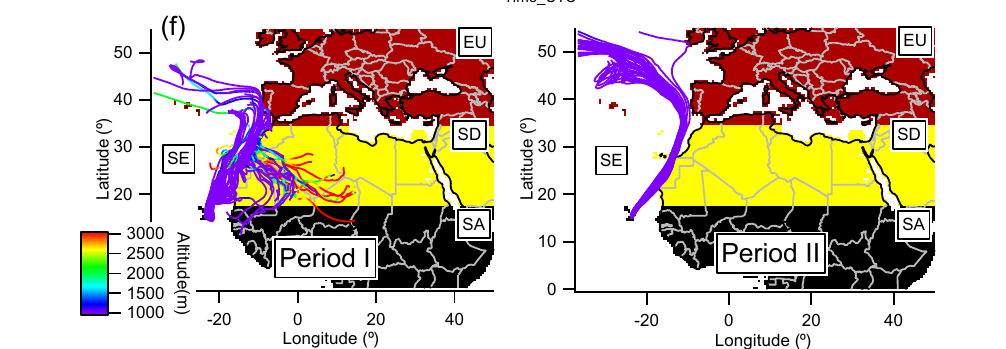
Figure 10. The results from ground measurements: time series of (a) BT air-mass-type transport days; (b) BT air-mass-type fraction; (c) the effective diameter at submicron and supermicron sizes; (d) aerosol mass (0.5–10µm); (e) the SP2-detected hematite mass and LAAP-TOF- detected number concentrations of silicate-containing particles; (f) the back-trajectory ensembles for Period I and Period